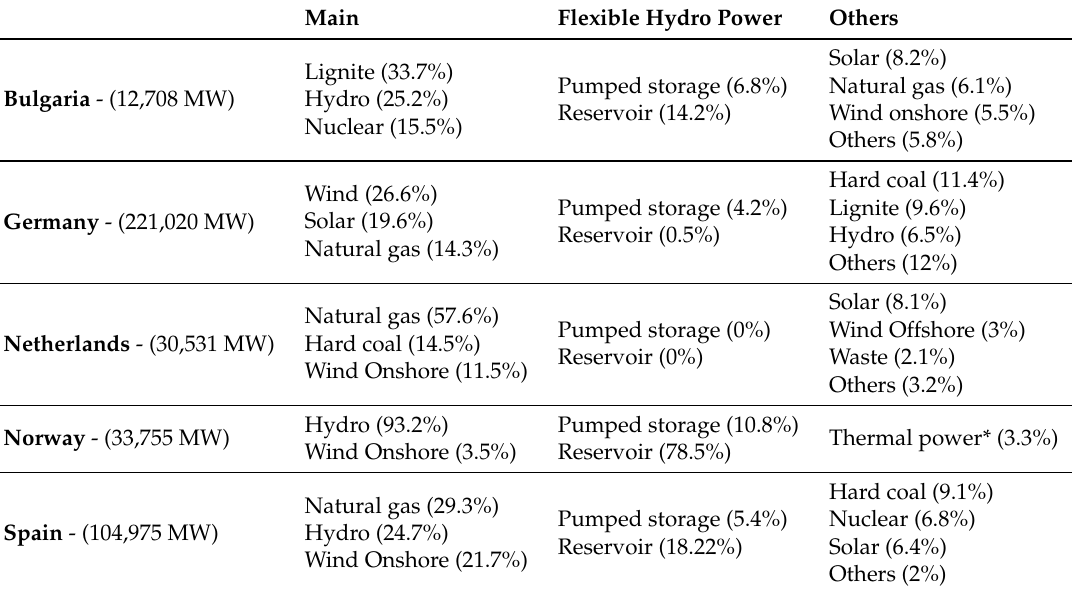
Table 2. Electricity installed capacity in the targeted countries for the year 2018. Main Flexible Hydro Power